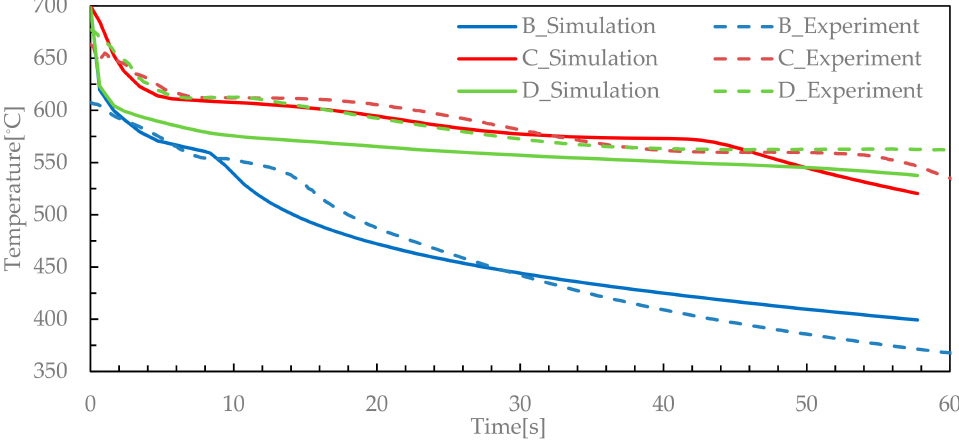
Figure 4. Comparison between the experiment data (dash) and simulated (solid) temperatures in the wheel. Silicon Mass Fraction Predictions . The predicted distribution of silicon in the wheel near the end taken vertically through the middle of the rim, as identified in Figure 5a. The scale range for the